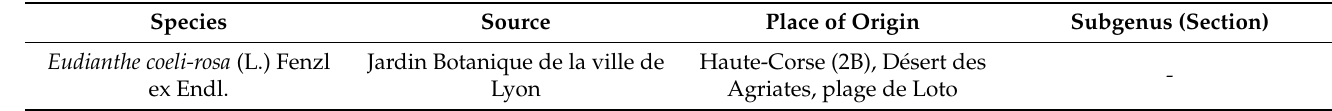
Table A2. Description of studied seeds of the genera Eudianthe and Silene , with the indication of the source and origin of the samples, based on the information given from the seed collection of the Botanical Garden of the University of Valencia (Spain). The name of the subgenus and the corresponding section (between brackets) are